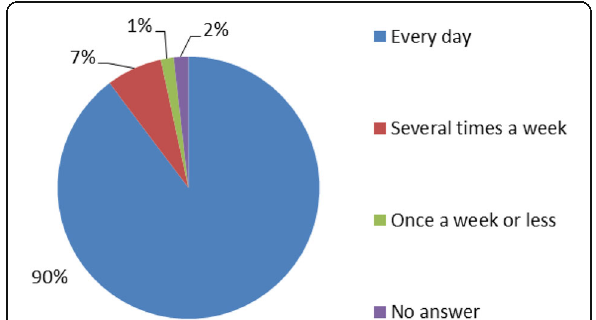
Fig. 5 The percentage division of children depending on the frequency of their consumption of milk or dairy